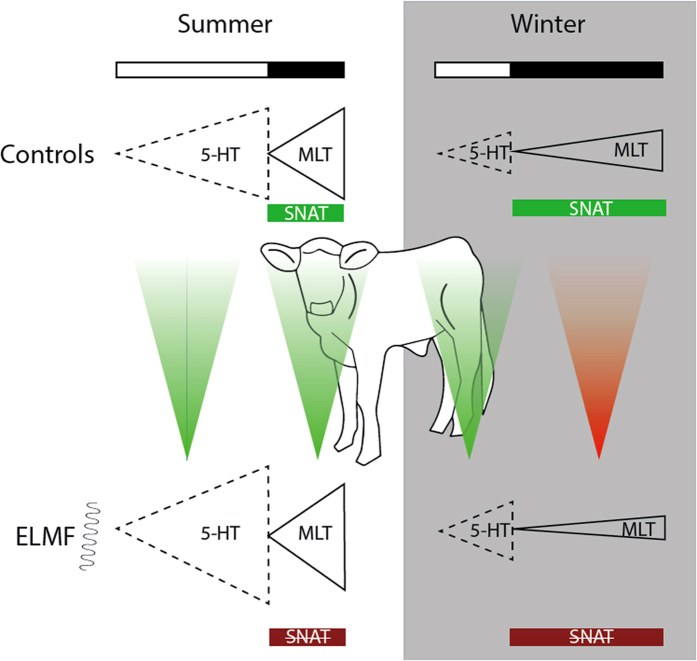
Possible explanation for the differential effect of ELFMF-exposure on MLT-levels in summer and winter.In the control calves (upper panel) the long photoperiod in summer leads to high amounts of accumulated serotonin (5-HT) at the end of the day when the serotonin N-acetyltransferase activity (SNAT, which is reduced through light exposure) starts to convert 5-HT into MLT. In winter, the short photoperiod prevents the synthesis of large 5-HT amounts and thus also caps MLT-levels. In the ELFMF-exposed calves (lower panel) the SNAT-activity is reduced at day- and nighttime. This leads to even higher 5-HT levels at daytime (not all of the 5-HT is converted to MLT during the night), especially during the long summer photoperiods (in addition, the 5-HT synthesis might be directly enhanced by ELFMF-exposure). In summer, this increased daily serotonin production overrides the effects of reduced SNAT activity at night, leading to higher MLT levels than in control calves. In winter, however, the photoperiod is too short for the 5-HT promoting effect of ELFMF to be of significance, leading to only a marginal increase in 5-HT. On the other hand, the longer dark period enhances the inhibiting effect of ELFMFs on SNAT activity, leading to lower MLT levels in exposed calves. Green indicates an increase or in the case of SNAT an active period. Red indicates a decrease or period of reduced activity, respectively. The dashed lines indicate that 5-HT levels were not measured in this study. (Author of the figure: E. P. Malkemper)